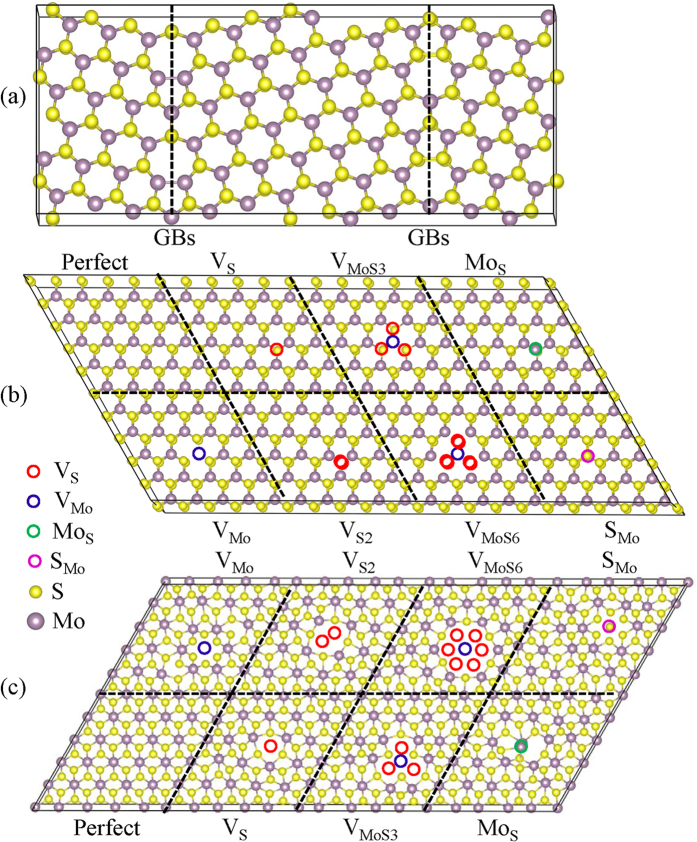
Atomistic configuration of MoS2 with defects.Optimized atomistic configurations of (a) grain boundary and defects including VMo, VS, VS2, VMoS3, VMoS6, SMo in (b) 2H-MoS2 and (c) 1T-MoS2 monolayers.